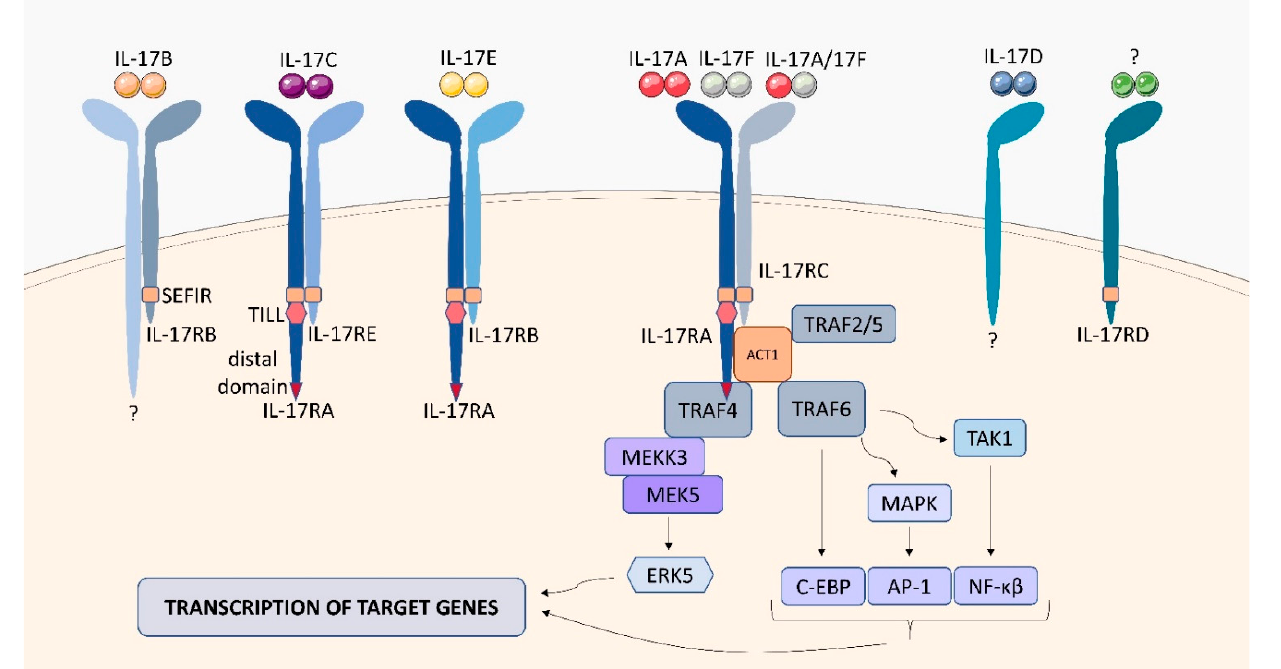
Figure 15. Structure and signaling of receptors of the IL-17 family. IL-17 receptor family includes IL-17RA, IL-17RB, IL-17RC, and IL-17RD, which can exist as homodimers (IL-17RD) and hetero- dimers (IL-17RB/?,IL-17RA/RE, IL-17RA/RB, IL-17RA/RC). The interaction of IL-17 with IL-17R leads to the activation of NF- κ B, MAPK, AP-1, C/EBP, and ERK5, which stimulate the transcription of genes in the cell nucleus, leading to the production of